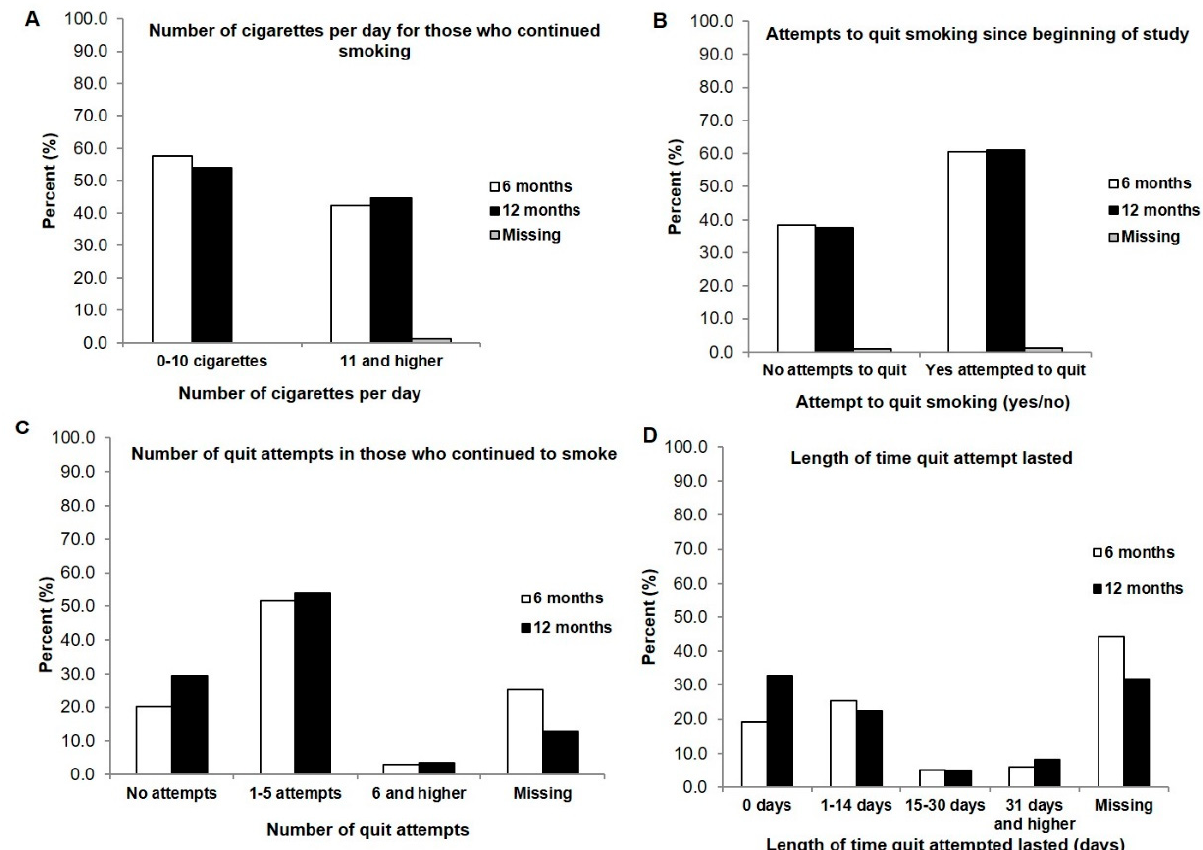
Figure 3. Participants who continued to smoke after presentation of a clinical tobacco intervention at 6 months ( n = 99) and 12 months ( n = 85) ( A ) Number of cigarettes smoked per day at 6 months and 12 months ( B ) Attempted to quit at 6 months and 12 months (yes/no) ( C ) Number of quit attempts made by those who smoke at 6- and 12-months ( D ) Length of time quit attempt lasted before beginning to smoke again at 6 and 12 months.